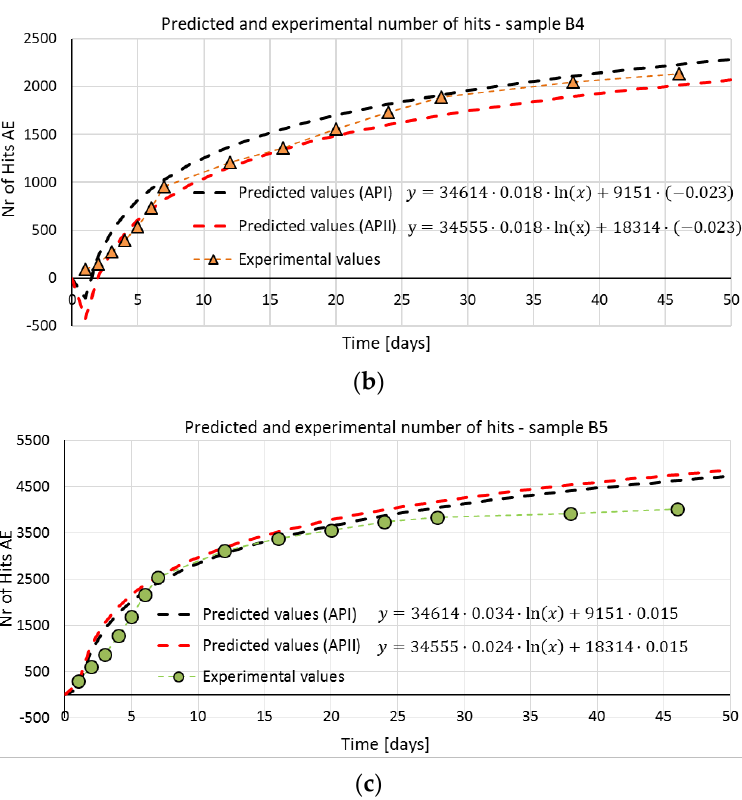
Figure 11. The results of the number of hits predicted (based on strain measurements) and recorded in samples: ( a ) C − I (MC), ( b ) C − III (MC) (series subjected to curing) and ( c ) C − III (AC).